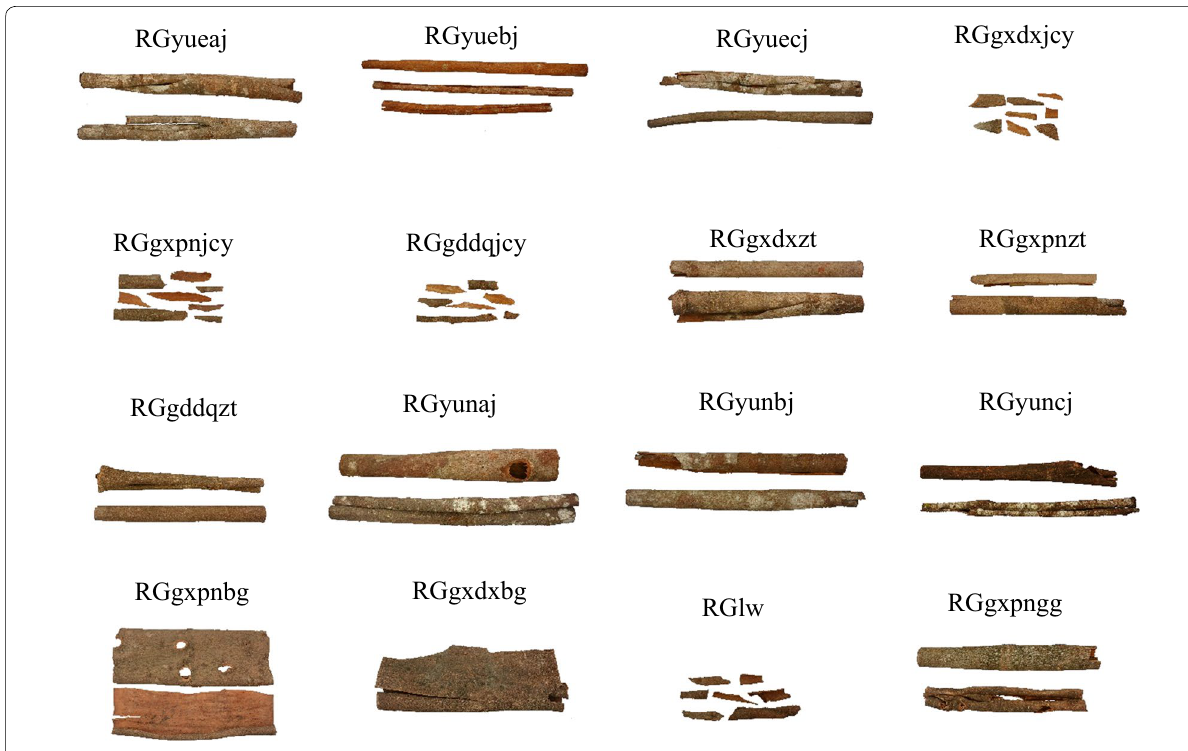
Fig. 1 The characteristic appearance of cinnamon materials